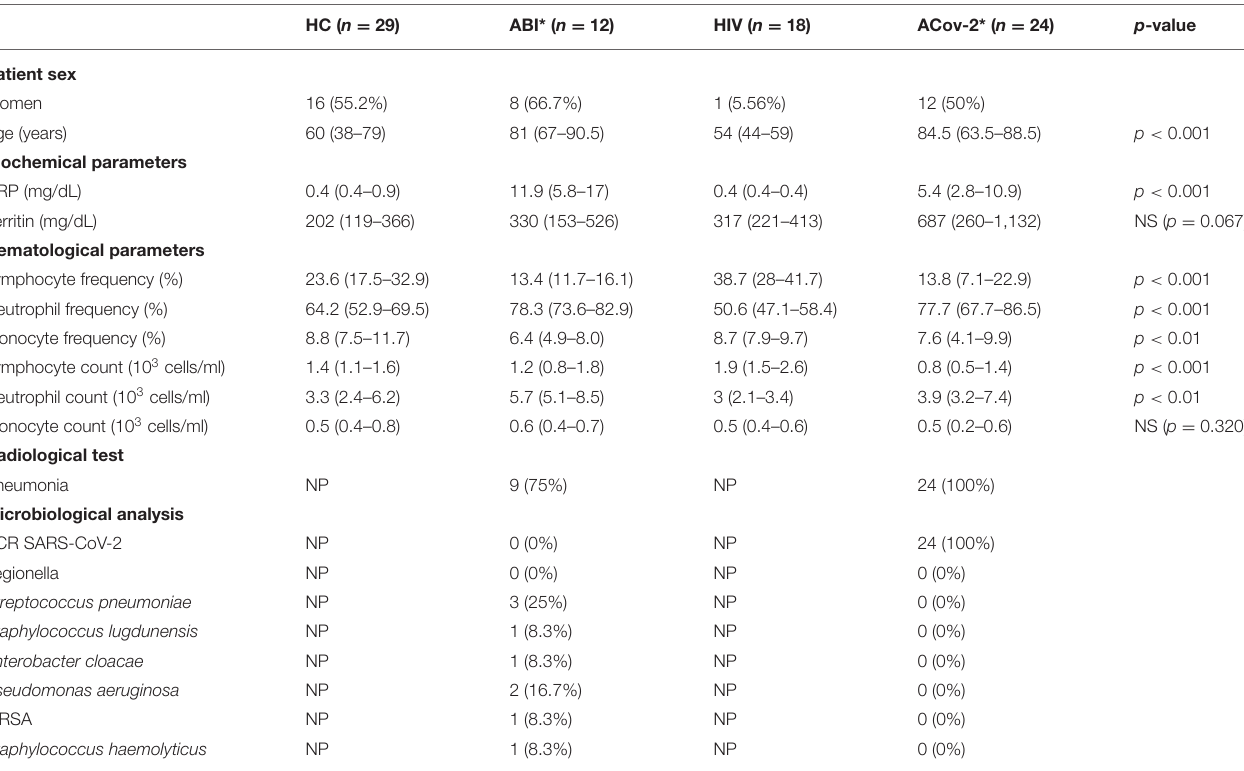
TABLE 1 | Demographic and analytical parameters in the different